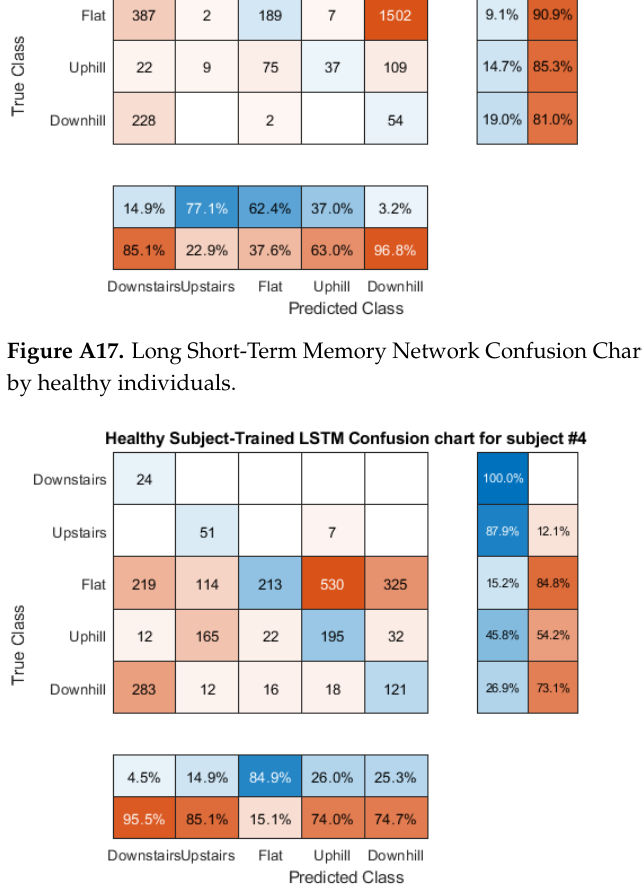
Figure A18. Long Short-Term Memory Network Confusion Chart for ILLA participant A4 as trained by healthy